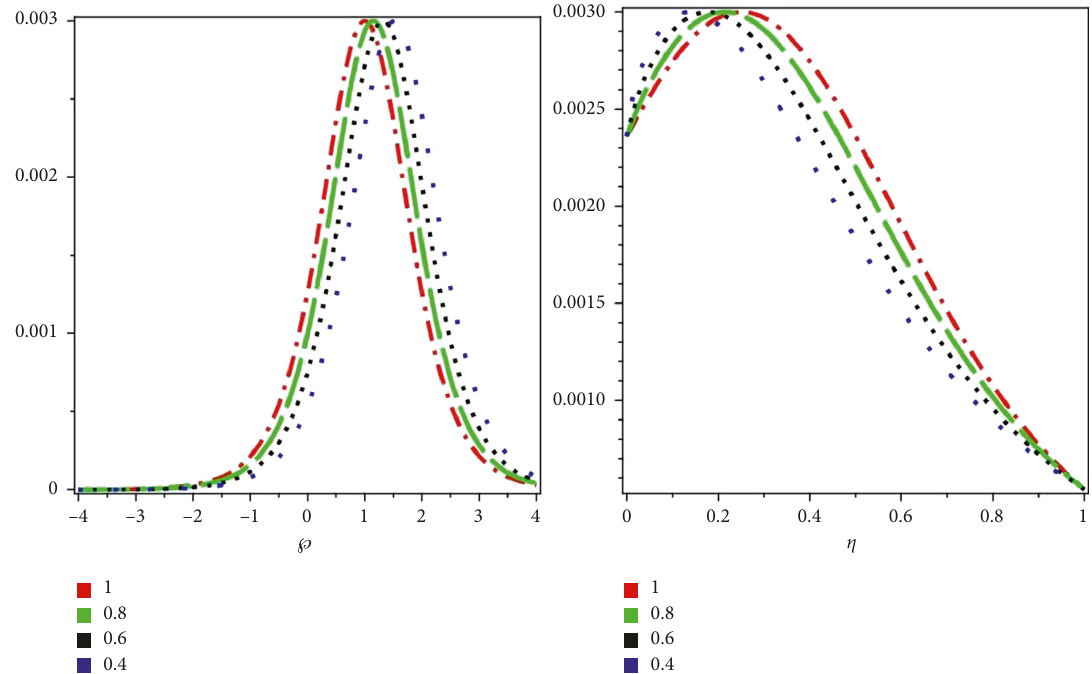
Figure 2: First figure show that the analytic result of various fractional-order of problem 2 and second graph with respect to